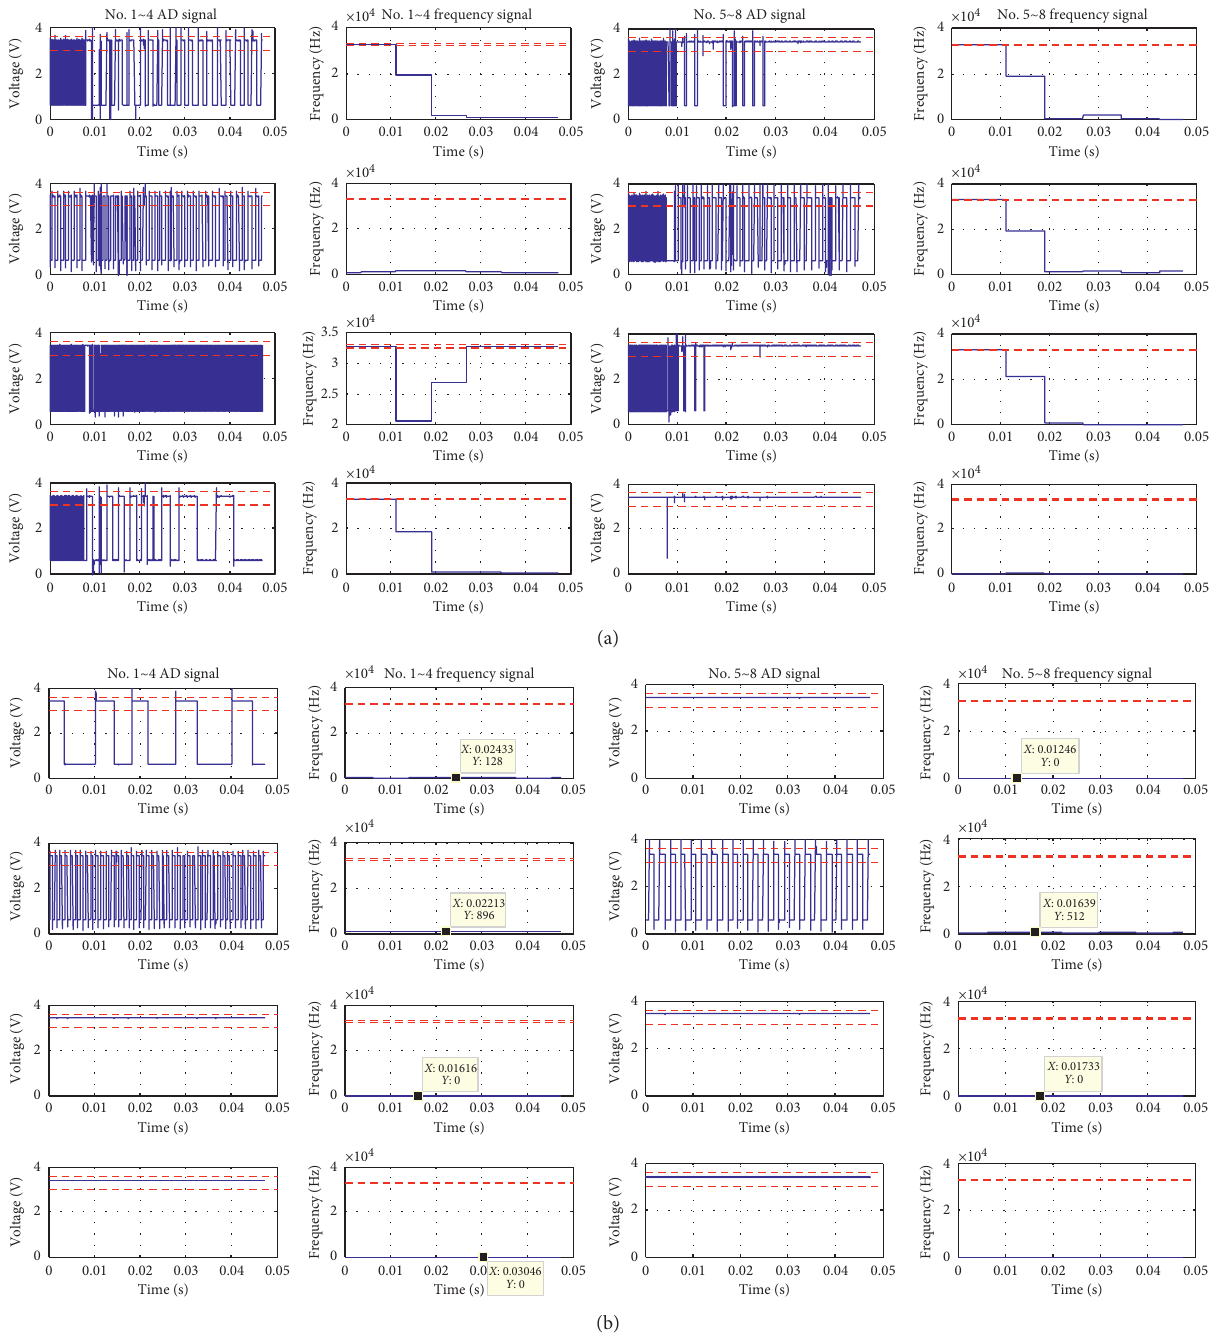
Figure 16: Electrical performance of the crystal oscillators on test board C1 under higher SRS. (a) Signals monitored during the loading process. (b) Signals monitored after the loading